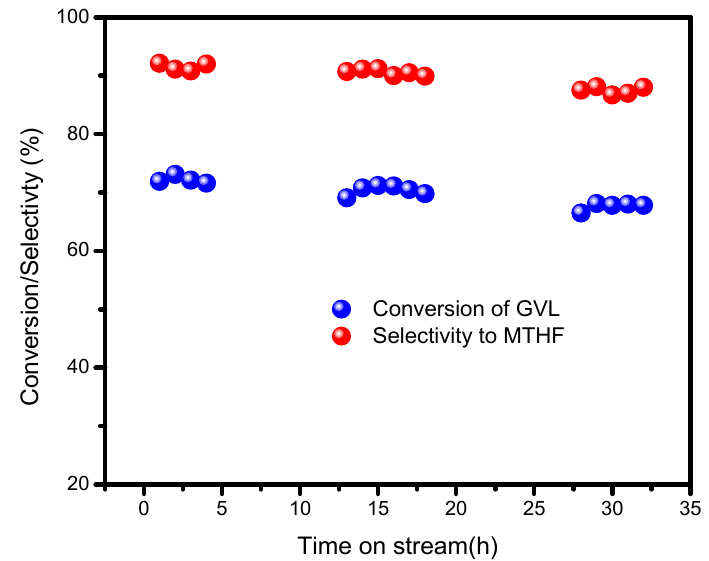
Figure 11. Time on stream study of the 5 wt% Cu/SiO 2 catalyst.